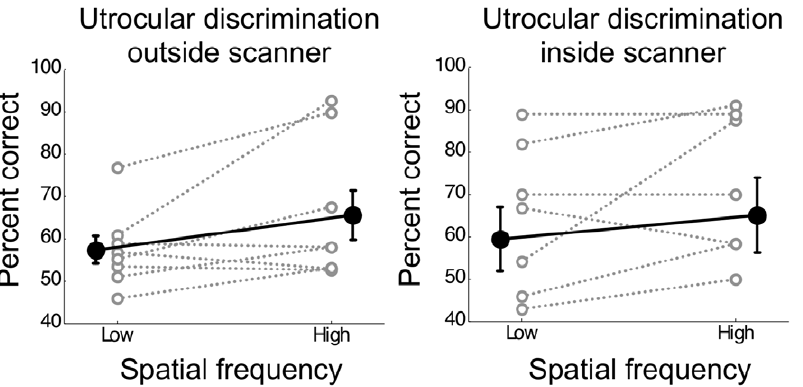
Figure 4. Utrocular discrimination outside the scanner and inside the scanner. Behavioral accuracy for judging which eye saw the grating stimulus is plotted for the low and high spatial frequency. Grey lines and open circles denote the performance for individual participants. Black line and solid circles denote the mean across participants (error bars depict standard error of the mean). doi:10.1371/journal.pone.0013775.g004 (Figure 5). We observed above chance decoding for all the retinotopic visual areas.